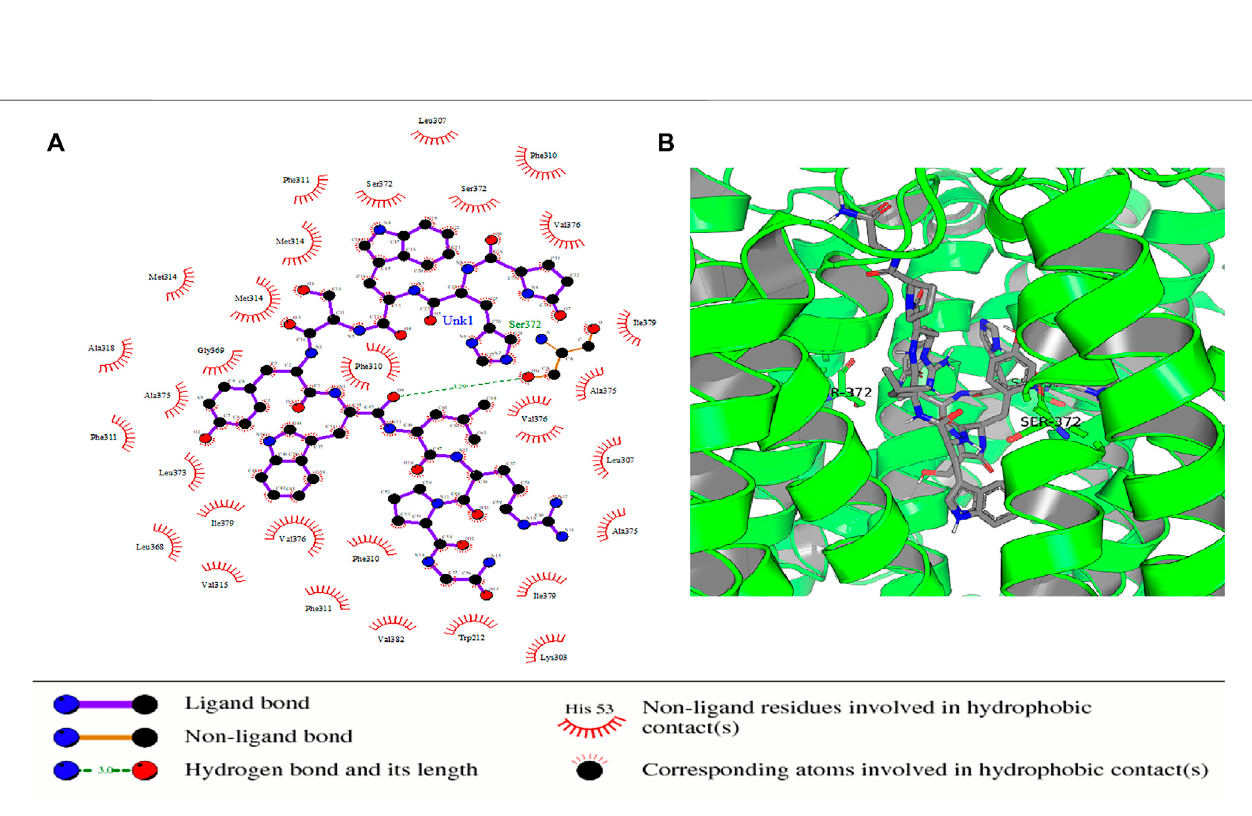
Frontiers in Bioinformatics |